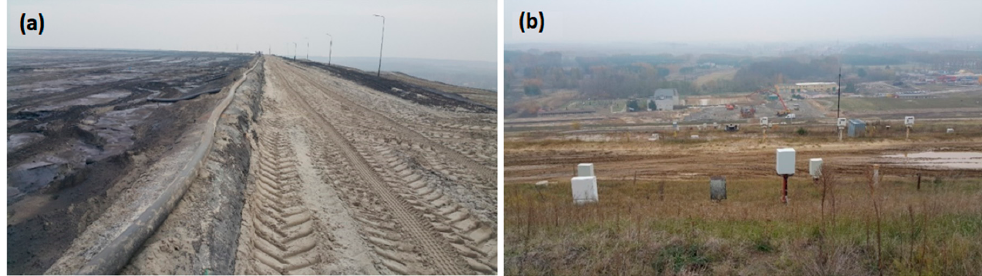
Figure 2. Photographs of earth embankment: ( a ) the earth embankment around the tailings pond, ( b ) the measuring equipment.